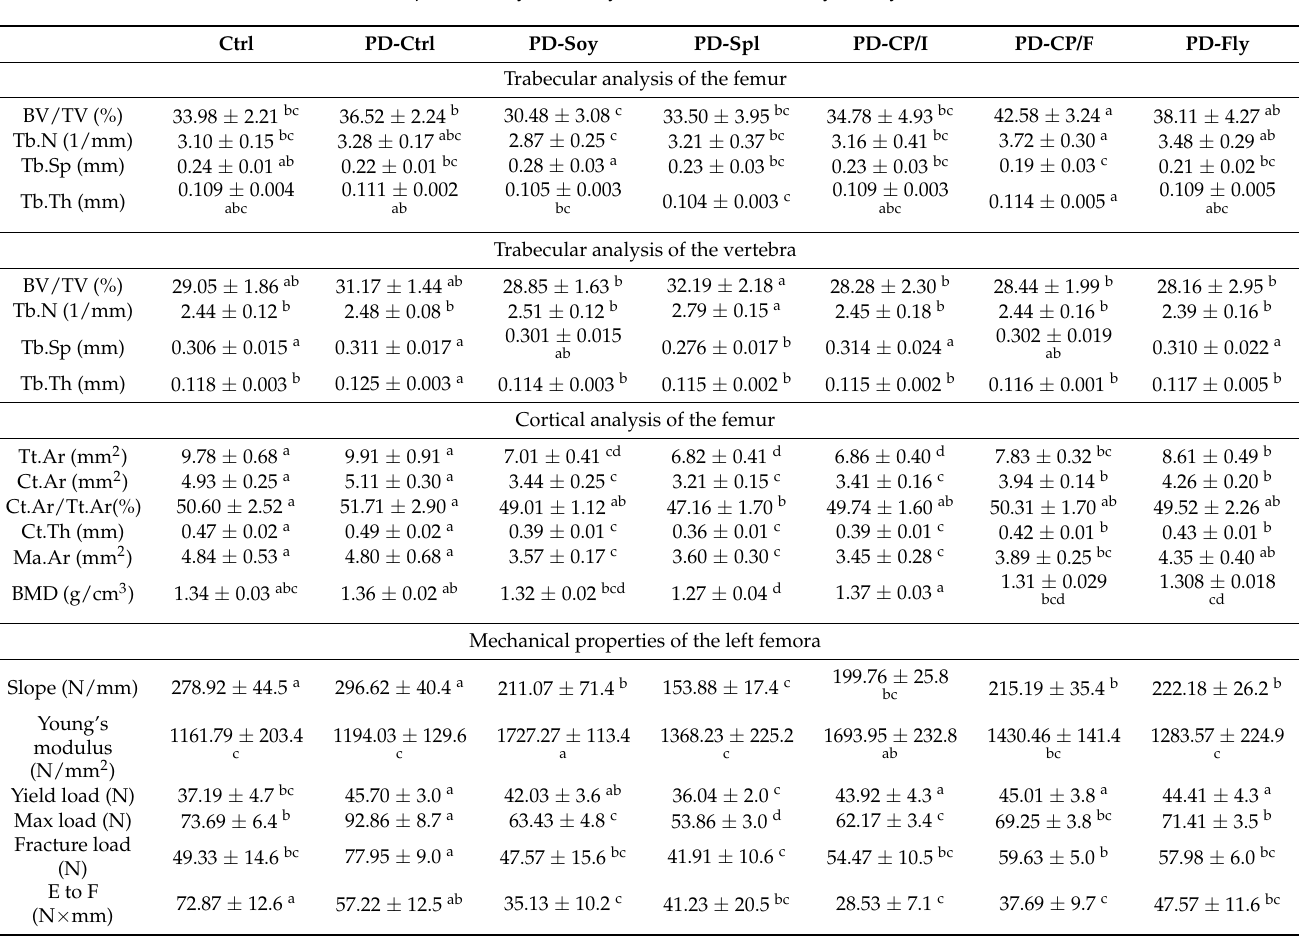
Table 4. Morphometric and mechanic characteristics. Bones were scanned by Micro-CT to deter- mine geometric parameters. After reconstructing 2D and 3D analyses were performed. Trabecular bone parameters: Bone volume over total volume, BV/TV (%); Trabecular number, Tb.N (1/mm); Trabecular separation, Tb.Sp (mm); Trabecular thickness, Tb.Th (mm). Cortical bone parameters: Total Cross-Sectional Area, Tt.Ar (mm 2 ); Cortical Bone Area, Ct.Ar (mm 2 ); Cortical area fraction, Ct.Ar/Tt.Ar (%); Cortical thickness, Ct.Th (mm); Medullary area, Ma.Ar (mm 2 ); Bone mineral den- sity, BMD (g/cm 3 ). Mechanical properties were evaluated using a three-point bending experiment. Biomechanical parameters obtained from load–displacement curve: Slope (N/mm); Young’s modulus (N/mm 2 ); Yield load (N); Max load (N); Fracture load (N); Energy to fracture, E to F (N × mm). Values are expressed as mean ± SD of n = 8 rats/group, different superscript letters are significantly different ( p < 0.05) by one-way ANOVA followed by Tukey’s